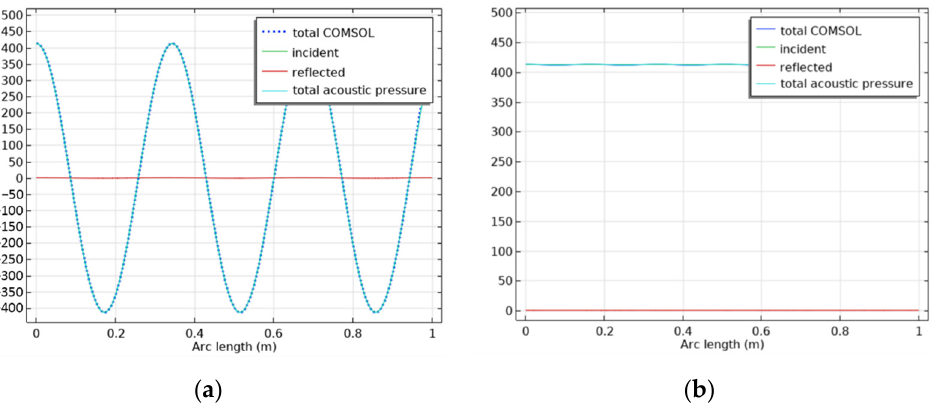
Figure 5. Simulation results of the 3D duct model in COMSOL: ( a ) real part of the pressure field in Pascal and ( b ) amplitude of the pressure field at f = 1000 Hz in Pascal.